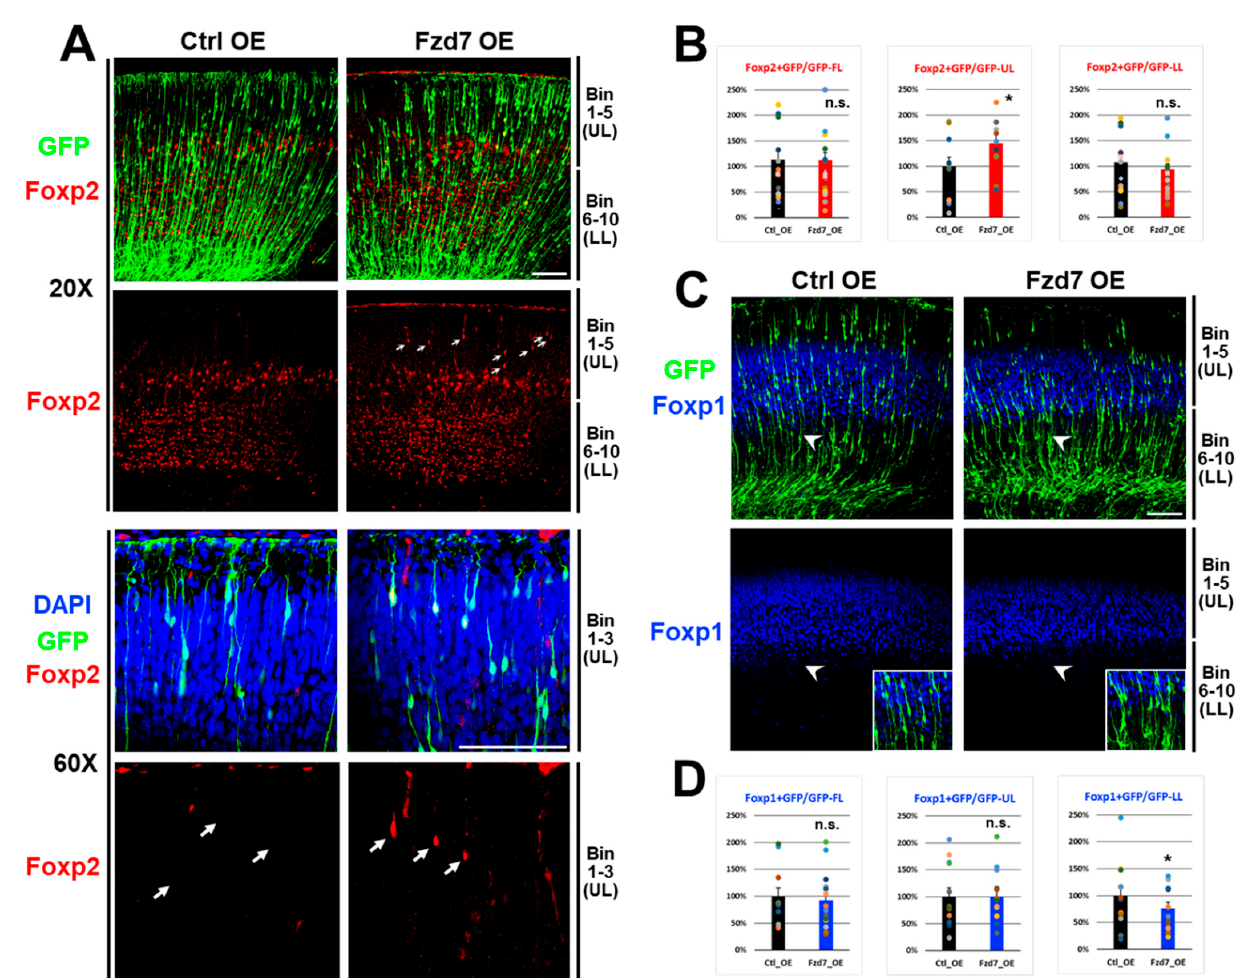
Figure 6. Foxp2 upregulation in UL and Foxp1 downregulation in LL with Fzd7 OE at P0 (E16 - P0). ( A ) and ( C ). IHC for GFP cells (green) with Foxp2 (red in A ) or Foxp1 (blue in C ) immunostaining in P0 neocortices electroporated in utero with Ctrl or Fzd7 OE plasmid at E16 ( n = 3 animals). Arrow in A : Foxp2 protein expressed in upper layer bins 1–3 with the Fzd7 overexpression; arrowhead area in C : Foxp1 expression reduced in lower layer bins 6–7 with the Fzd7 overexpression, which are shown with higher magnification images in the insert. DAPI shown in blue ( A ); Bin 1–5: upper layers (UL); Bin 6–10: lower layers (LL); scale bar: 100 µm. ( B ) and ( D ). Quantification of Foxp2- ( B ) or Foxp1- ( D ) positive cells ( n = 10–20 pictures counted with total 1711–3358 GFP cells), normalized to the Ctrl shRNA (100%). Data represent the mean and SEM. FL; full layers (Bin 1–10); statistics: Student’s t-test; *: p < 0.05; n.s.: not significant.